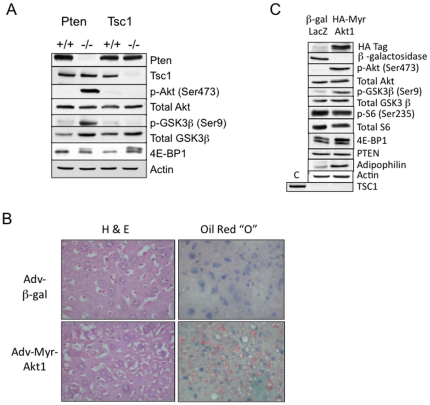
Akt induces steatosis in the Tsc1−/− livers.A) Contrasting effects of Pten- and Tsc1-loss on Akt signaling in the liver. Immunoblot analyses of liver lysates from fasted 20 wk-old mice using indicated antibodies to highlight Akt and mTORC1 signaling. B) Effects of Akt on Tsc1−/− livers. Tsc1−/− mice were injected through the tail-vein with adenovirus (107 PFUs) encoding genes for Myr-Akt1 or β–galactosidase control. After 96 hours, mice were fasted overnight and sacrificed for H&E histology and Oil Red “O” staining of the livers. Magnification, 400X. C) Expression of transgenes (HA-tagged Myr-Akt1 or β–gal) and components of the Akt/mTORC1 pathway in the Tsc1−/− livers following adenovirus injections. C, control for Tsc1 expression. Note up-regulation of Akt without significant alteration to mTORC1 signaling in the Myr-Akt1-treated liver.